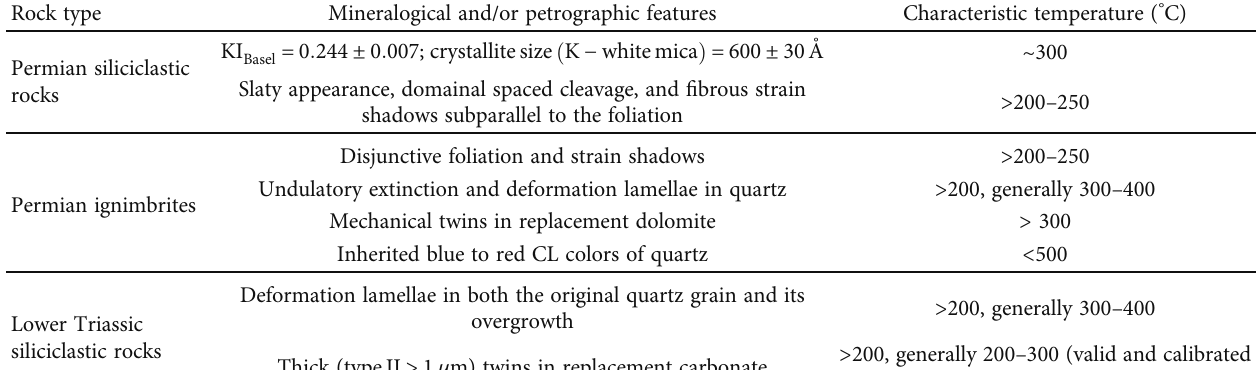
Table 2: Temperature-dependent structural and textural features of the studied rock samples.